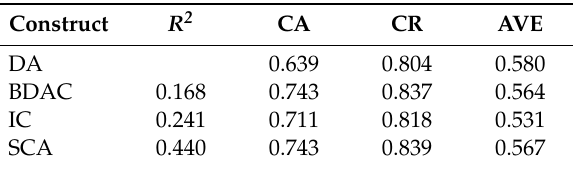
Table 2. Results of reliability and validity.